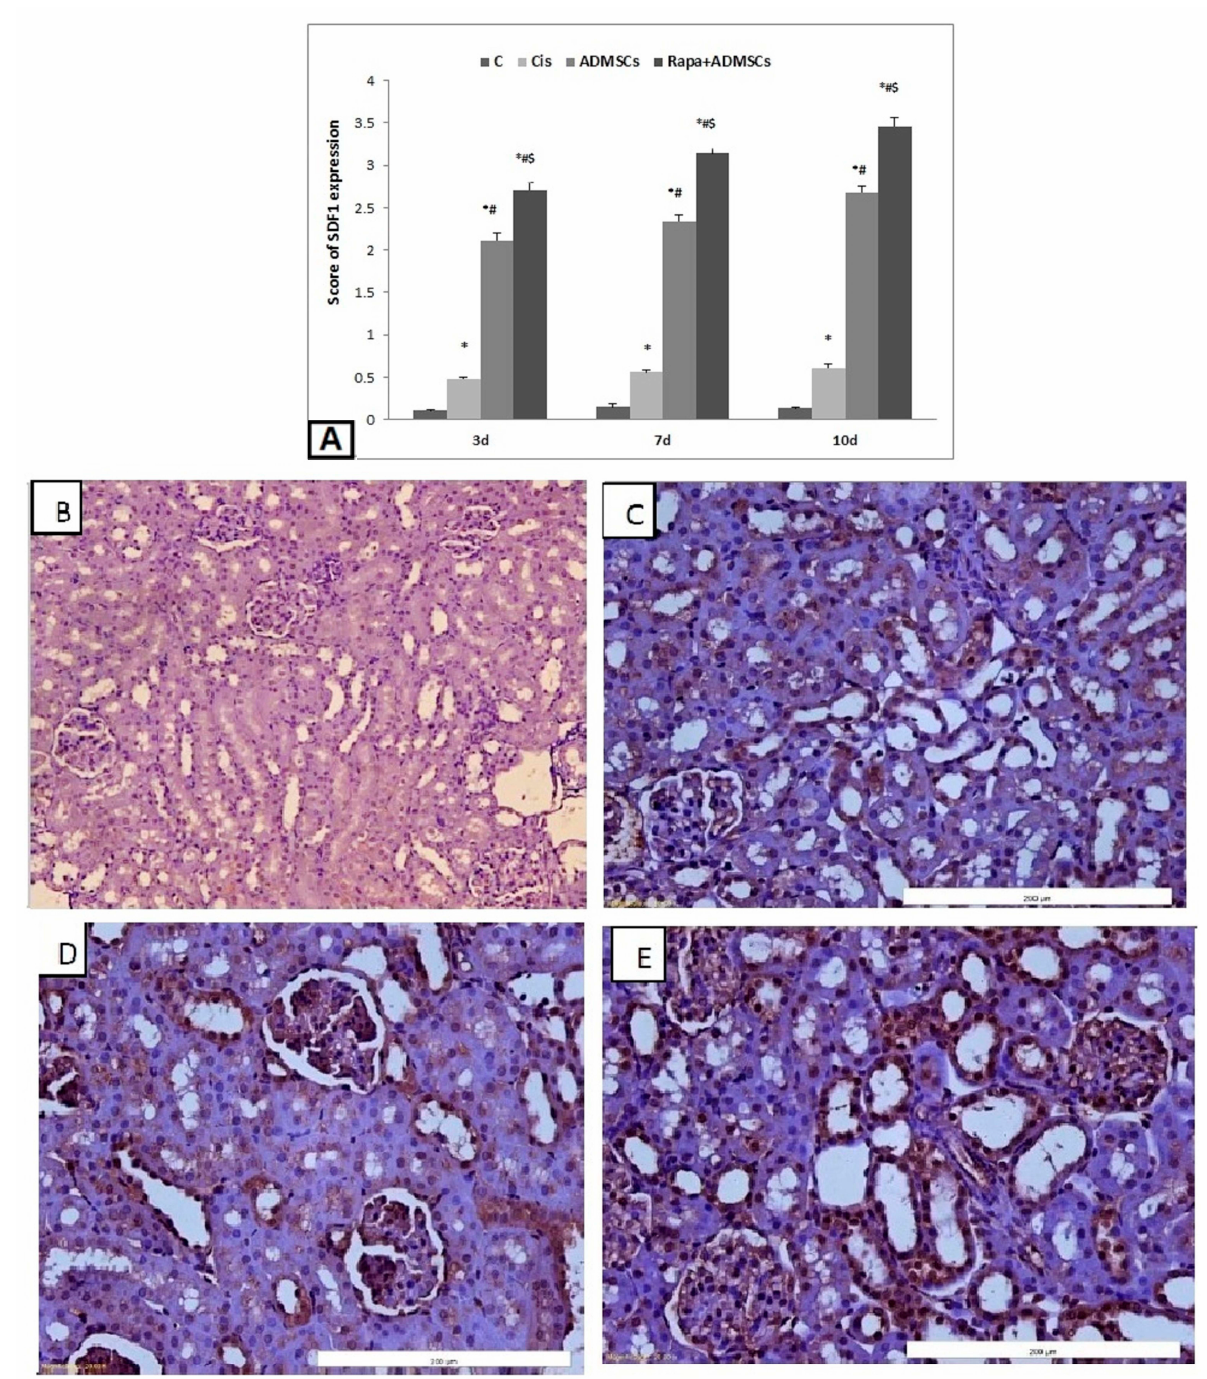
Figure 7. Immunohistochemical analysis of SDF1 α expression in kidney tissues 400×. ( A ) Im- munoscore of SDF1 α , ( B ) negative expression in control group, ( C ) mild expression in cisplatin group, ( D ) moderate expression in ADMSC group, ( E ) marked expression in Rapa + ADMSC group. * Significant vs. control, # significant vs. Cis group and $ significant vs. ADMSCs group. In addition, the score of LC3 expression was significantly higher in the Cis group than the control group ( p < 0.01), and its expression became higher in the ADMSC